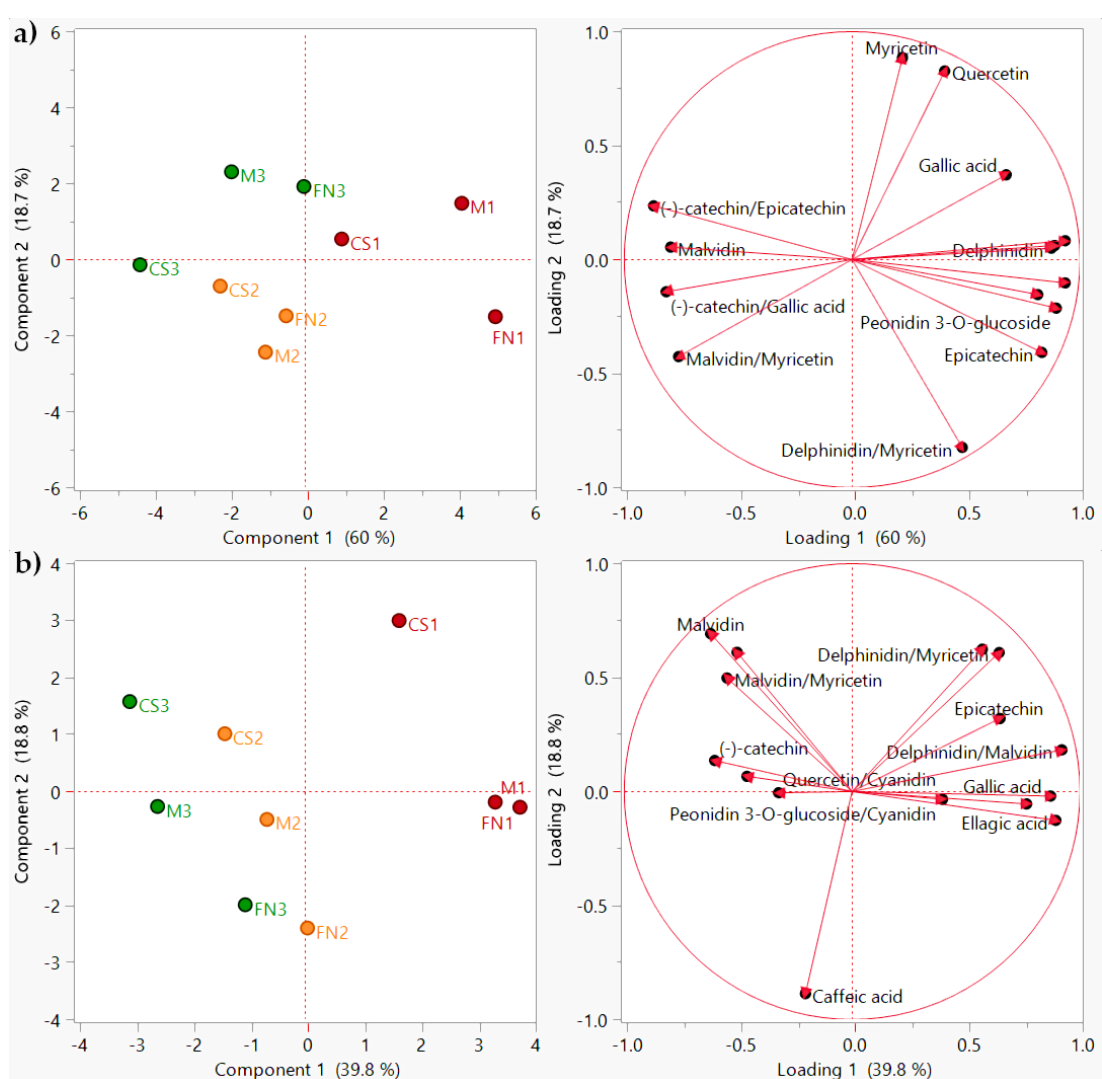
Figure 5. PCA diagram showing sample clustering (scores plot) and polyphenol distribution (loadings plot) during storage. ( a ) Stage 2–3 months; ( b ) Stage 3–6 months. Color coding: red—Murfatlar 2014; orange—Murfatlar 2015; green—Valea Călugărească 2015.